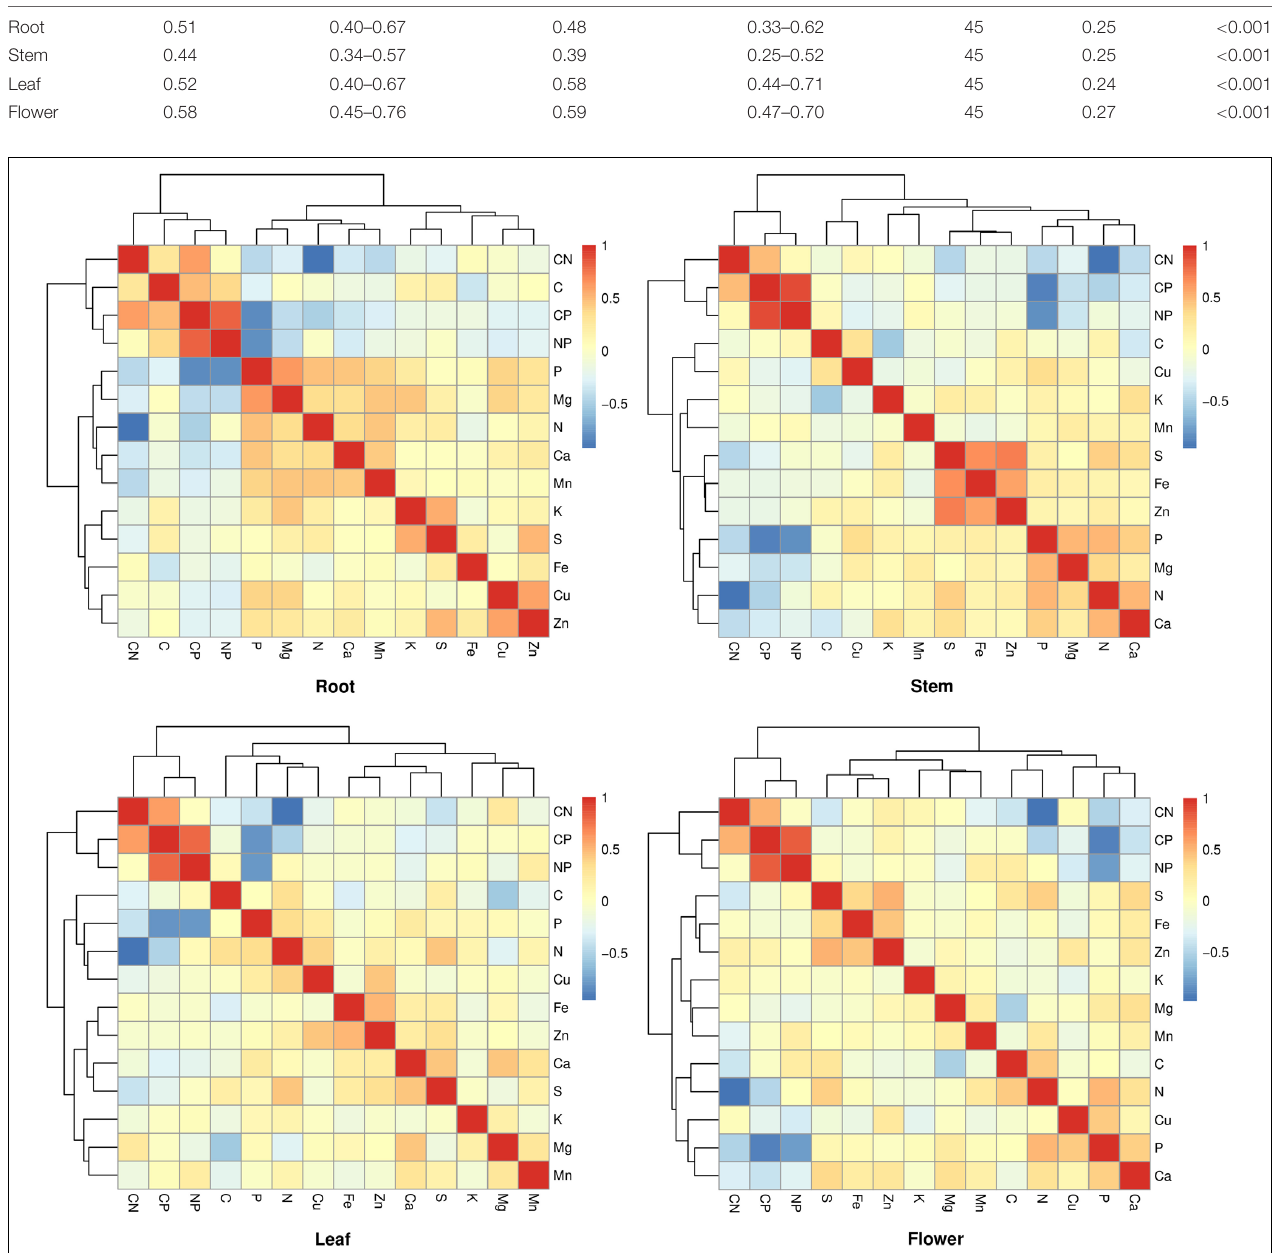
FIGURE 4 | Pearson’s correlation coefficients for the element contents and C, N, and P molar ratios in plant organs. The sample size is 45 for each plant